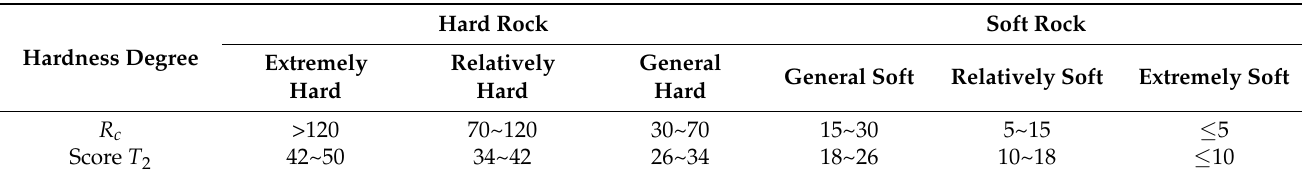
Table 7. Score of middle rock pillar hardness